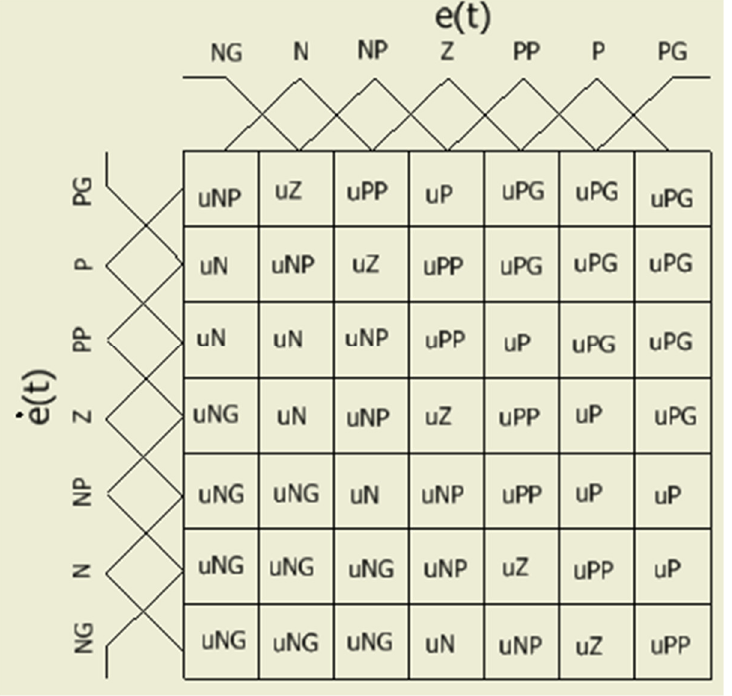
Figure 17. Matrix of rules for the integrative action. Once the set of rules was implemented, the control surfaces obtained for each stage were observed, as shown in Figures 18 and 19.